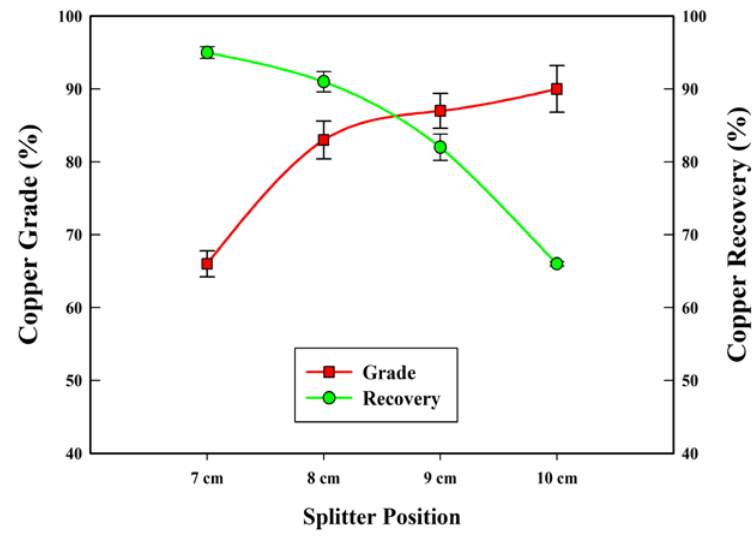
Figure 9. Effect of splitter position on grade and recovery of copper in induction electrostatic separation after sieving/washing (applied voltage: 20 kV, relative humidity: 35%, distance between electrodes: 60 cm).